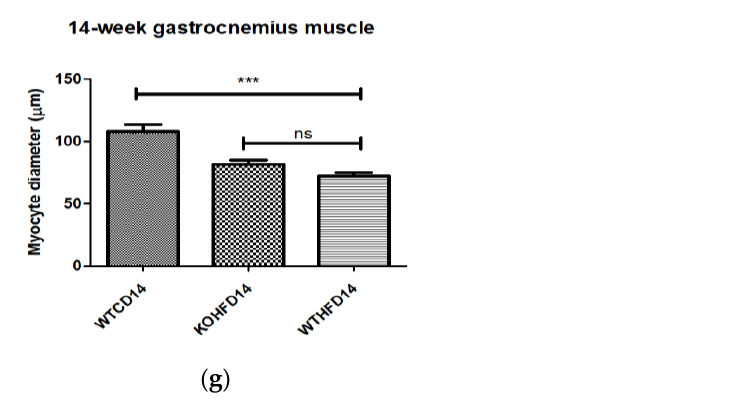
Figure 6. Effect of slc7a8 deletion on adipose tissue accumulation and myocyte atrophy in gas- trocnemius muscle. Myocyte atrophy was observed in WTHFD ( c ) when compared to WTCD ( a ) and KOHFD ( b ). WTHFD had significantly smaller ( p < 0.001) ( g ) myocytes than WTCD. Greater perimuscular adipose tissue (PMAT) accumulation was seen in WTHFD ( f ) than in WTCD ( d ) and KOHFD ( e ). N = 120 myocytes. *** p < 0.001